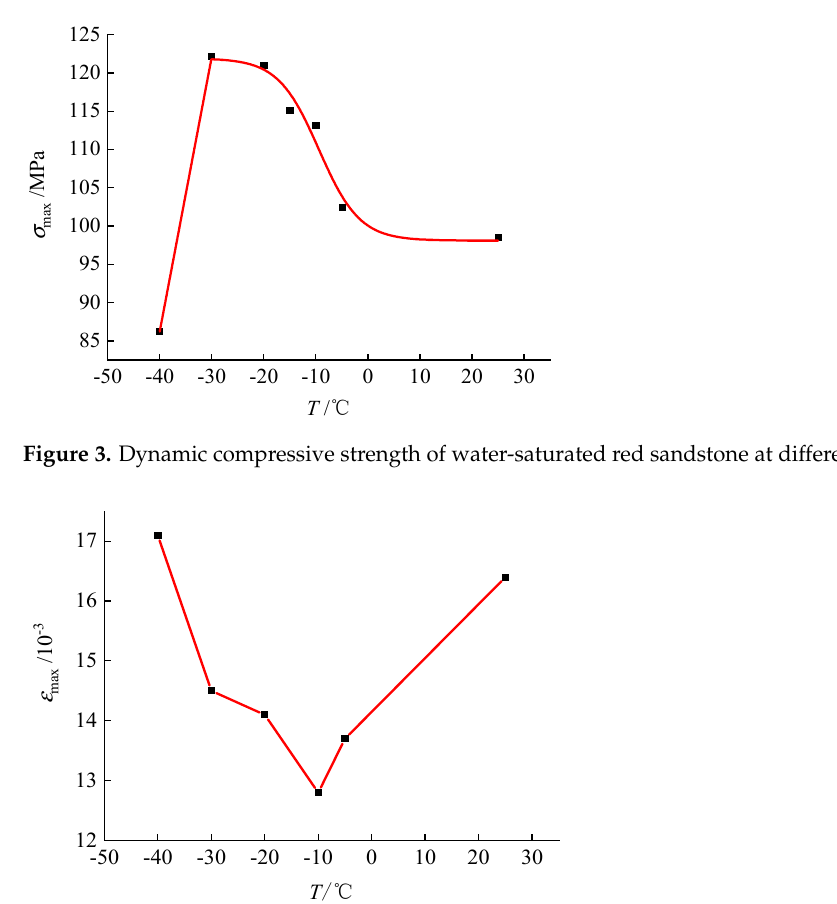
Figure 4. Failure strain change of water-saturated red sandstone at different temperatures.